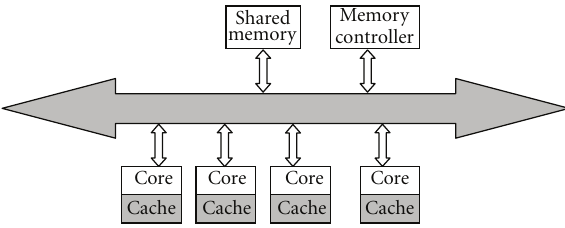
Figure 5: Proposed simulator